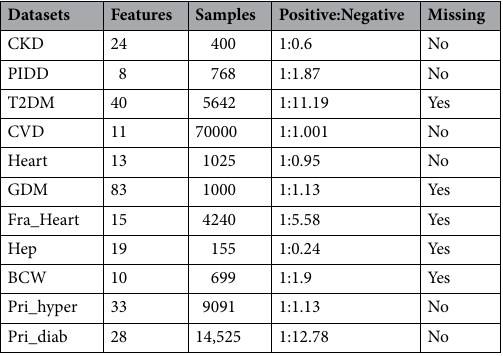
Table 1. The composition details of chronic disease